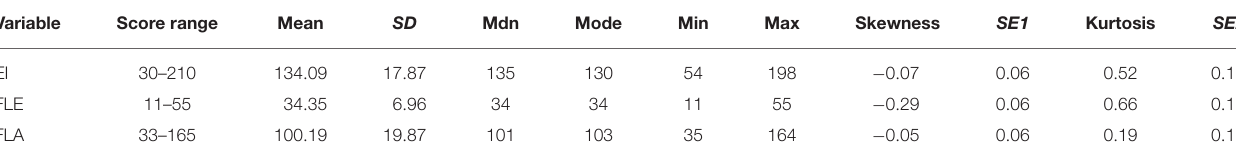
TABLE 2 | Descriptive statistics for emotional intelligence and classroom emotions ( N = 1,718).